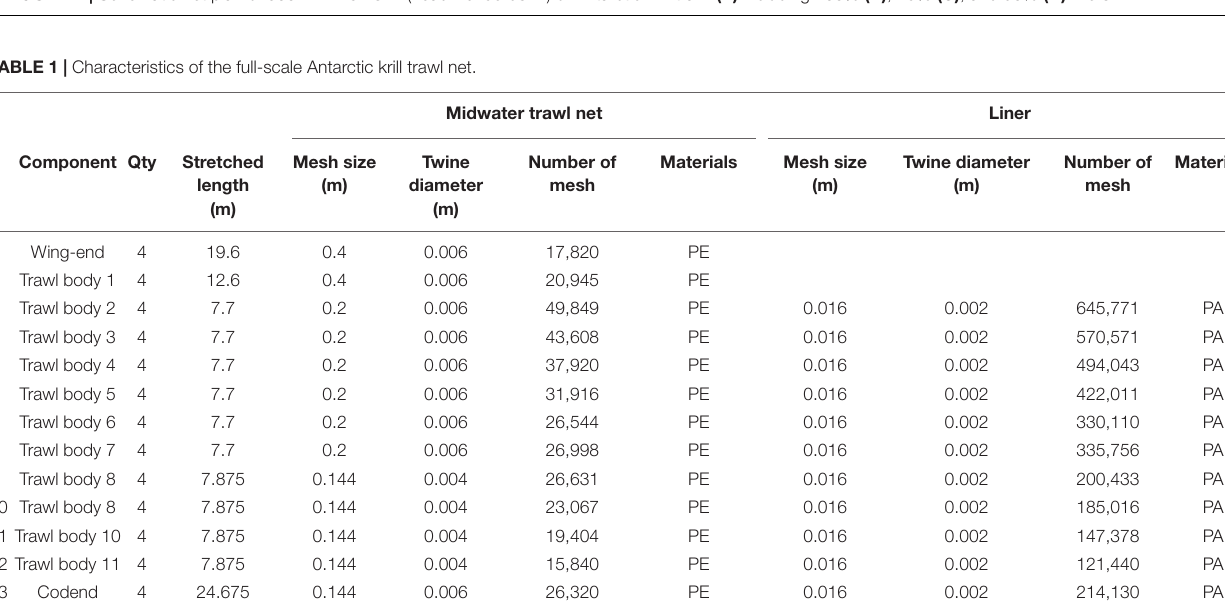
FIGURE 1 | Schematic net plan of 300 m × 132.8 m (headline: 55.68 m) of Antarctic krill trawl (A) including 100% (B) , 75% (C) , and 50% (D) liners.